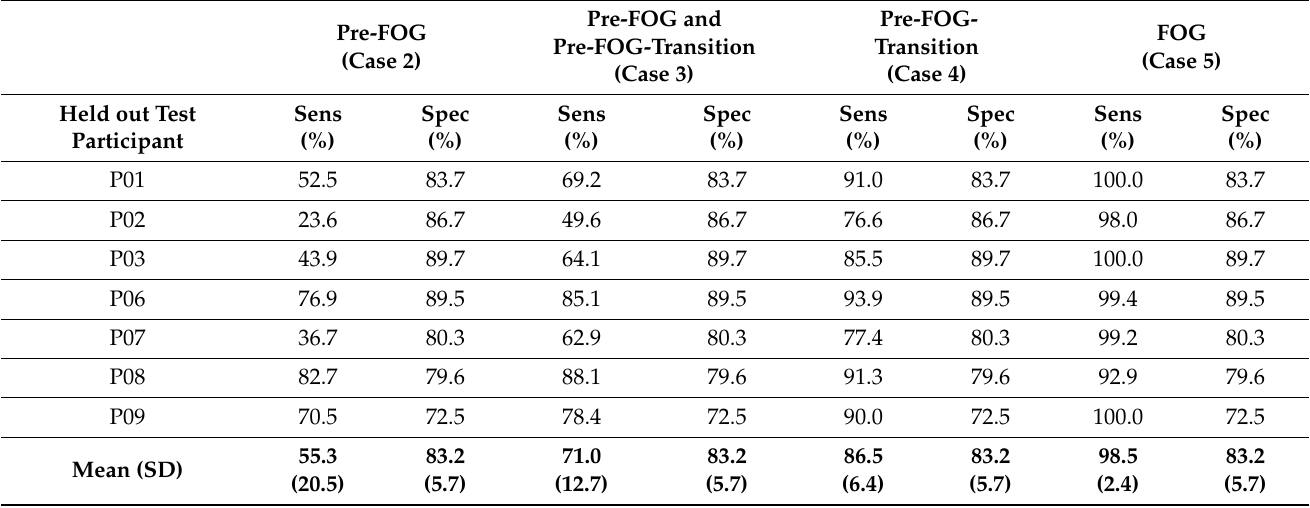
Table 7. Target class test cases for plantar pressure features model, using top 5 features according to Relief-F. Column headers are the label(s) included in the target class, as defined in Table 2.